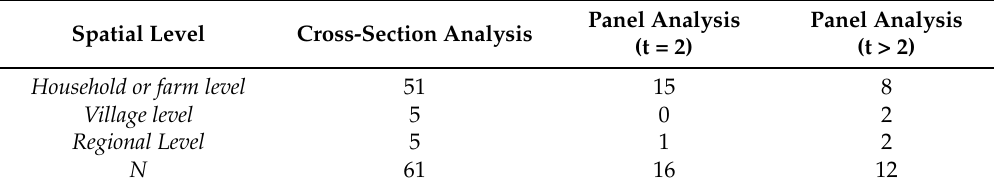
Table 5. Methodological approach in micro-level land-use change studies.